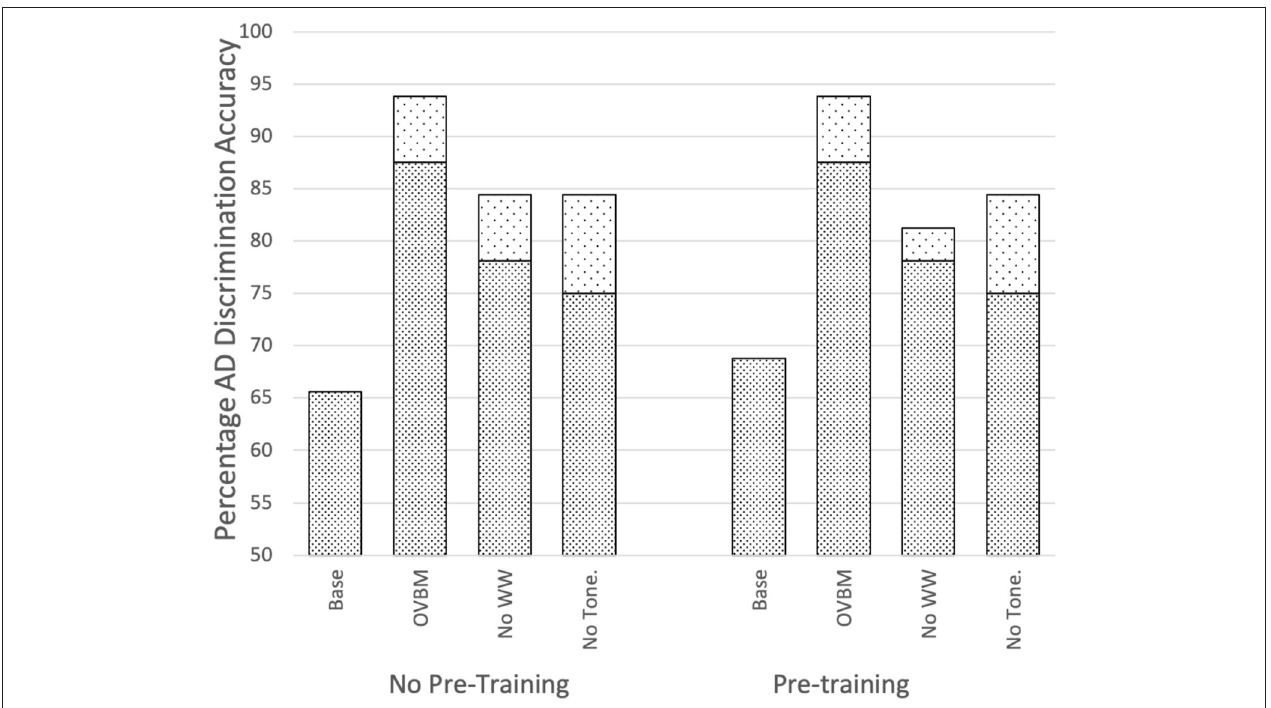
FIGURE 3 | Impact of sensory stream biomarkers on OVBM performance by removing transferred knowledge one at a time. Top dotted sections of bars indicate there is always performance gain from the cough biomarker. Baselines are the OVBM trained on AD without any transfer learning. In the other bars, a biomarker is removed and replaced with an AD pre-trained ResNet50, hence removing the transferred knowledge but conserving computational power, showing complementarities since all are needed for maximum